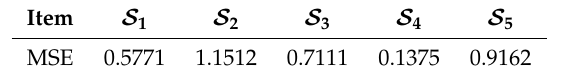
Table 1. Mean square error (MSE) of outputs between SCN-DMPC and cooperative DMPC.